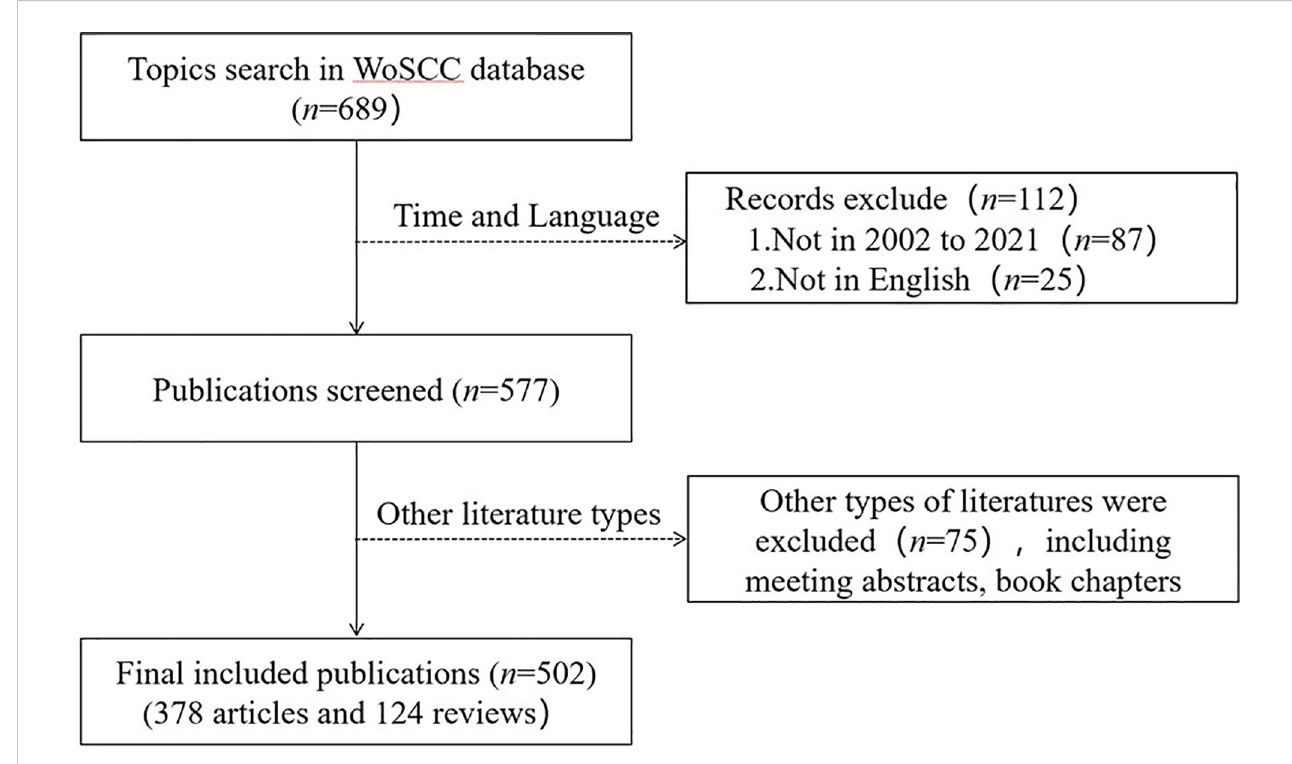
FIGURE 1 Flow chart of publication retrieval and